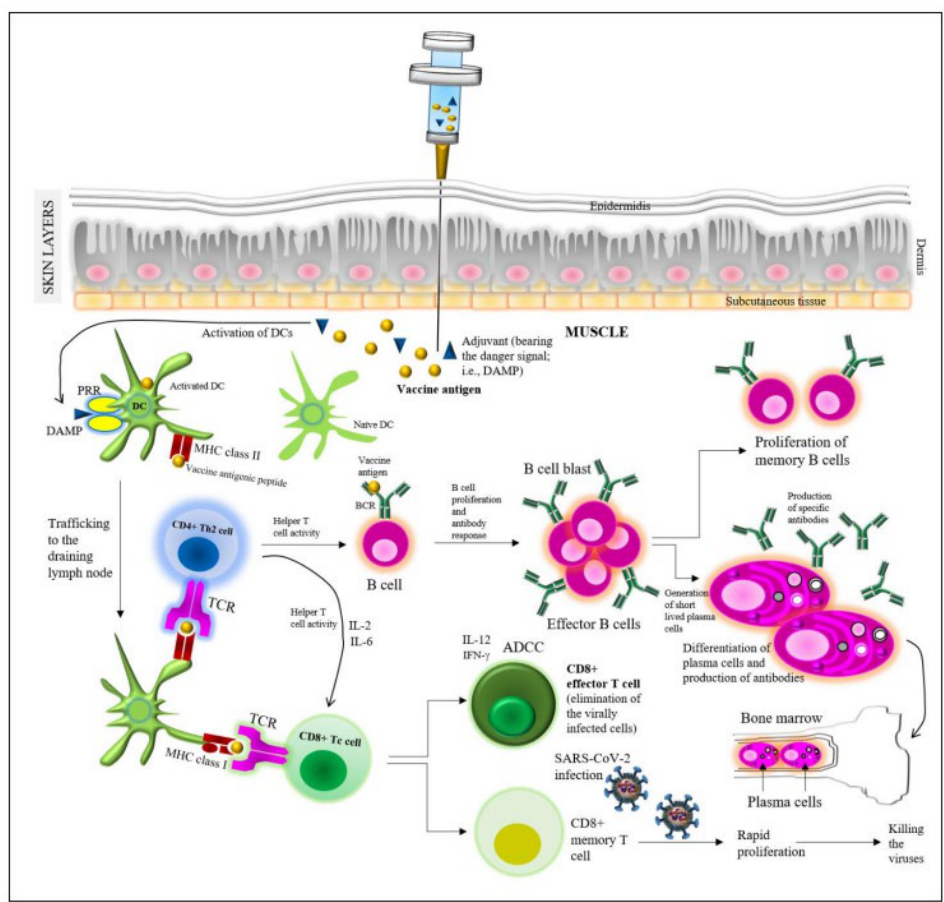
Figure 2. Vaccine-induced protection, adapted from Pollard and Bijker, 2021 [54]. Details are provided in the text.